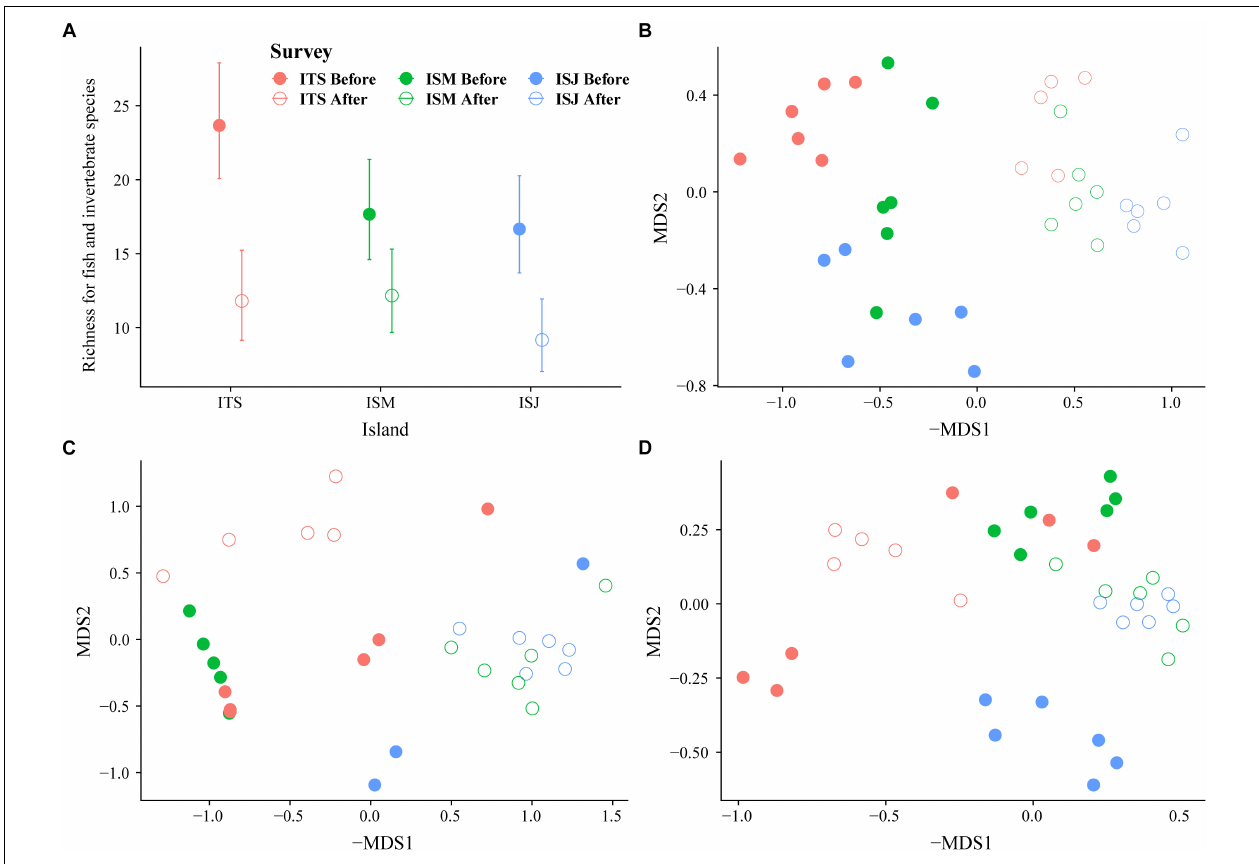
FIGURE 5 | Community change from before to after the MHW. (A) Changes in fish and invertebrate mean species richness from before to after the MHWs (95% confidence intervals) at the three islands. Estimates were drawn from models summarized in Table 2 . (B–D) Non-metric multidimensional (nMDS) scaling biplot of Bray-Curtis resemblance matrix computed on square-root transformed comparing (B) the fish and invertebrate, (C) the subcanopy, and (D) the understory algal assemblages among the three islands, Isla Todos Santos, Isla San Martin, and Isla San Jeronimo, and before and after the 2014–2016 warming event of the kelp forest community. Each symbol represents a